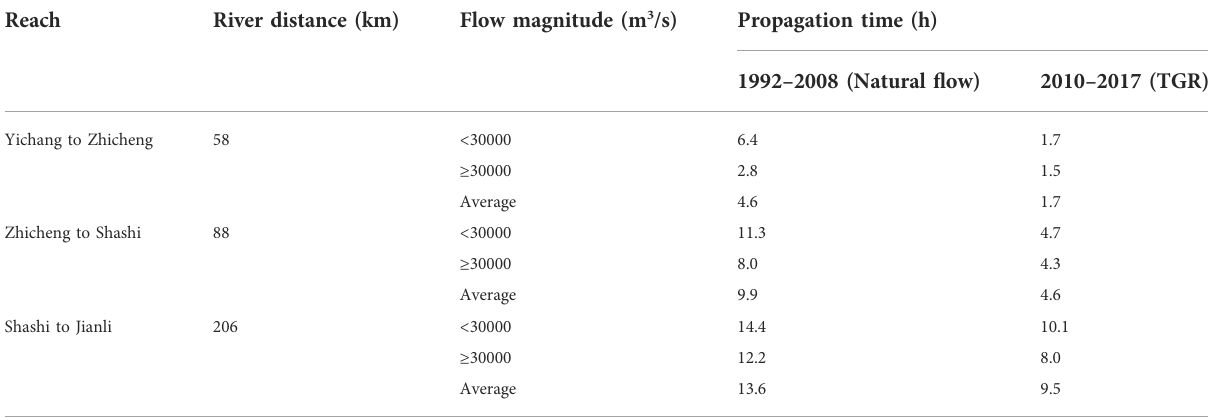
TABLE 2 Natural and post-TGR fl ood propagation time in the Jingjiang Reach.